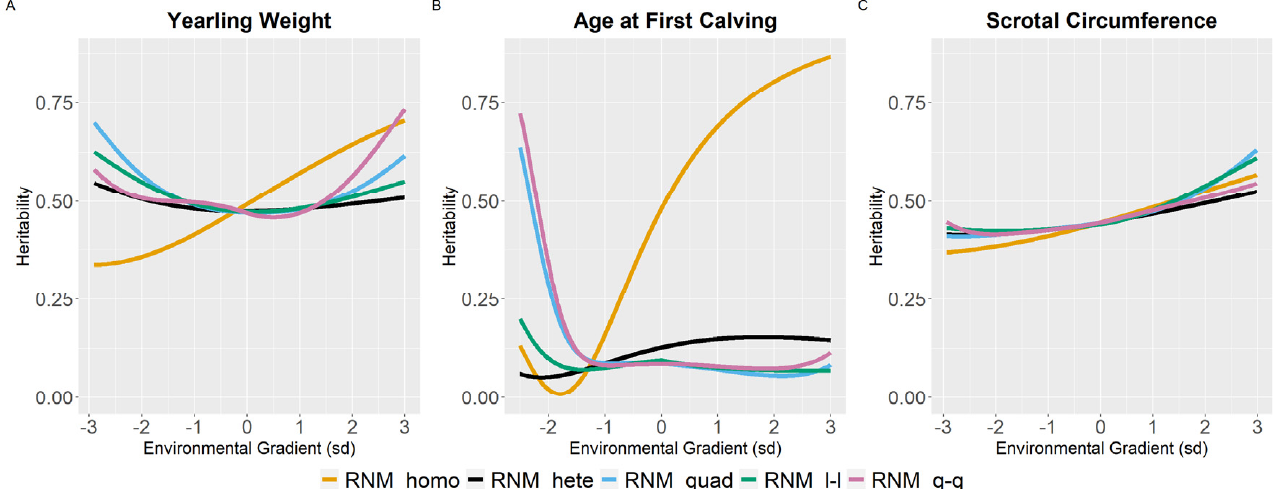
Figure 3. Heritability estimates (h 2 ) for yearling weight ( A ), age at first calving ( B ) and scrotal circumference ( C ) in Nellore cattle according to the environmental gradient, for different reaction norm models. RNM_homo: linear homoscedastic; RNM_hete: linear heteroscedastic; RNM_quad: quadratic heteroscedastic; RNM_l-l: spline linear–linear heteroscedastic; RNM_q-q: spline quadratic–quadratic heteroscedastic.